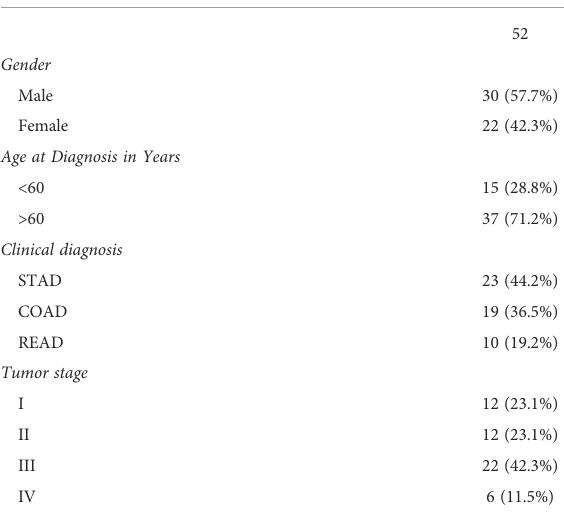
TABLE 1 Patients ’